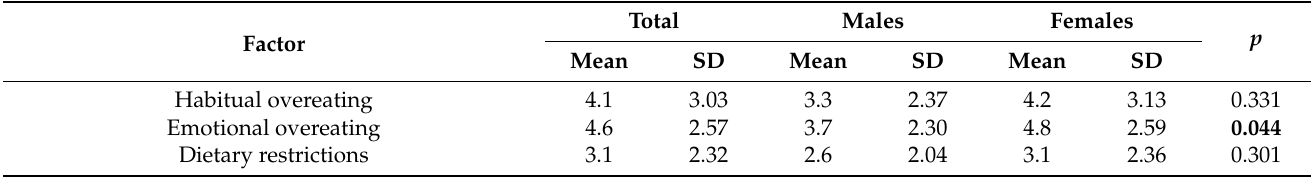
Abbreviations as in Table 4; p < 0.05 were indicated by using